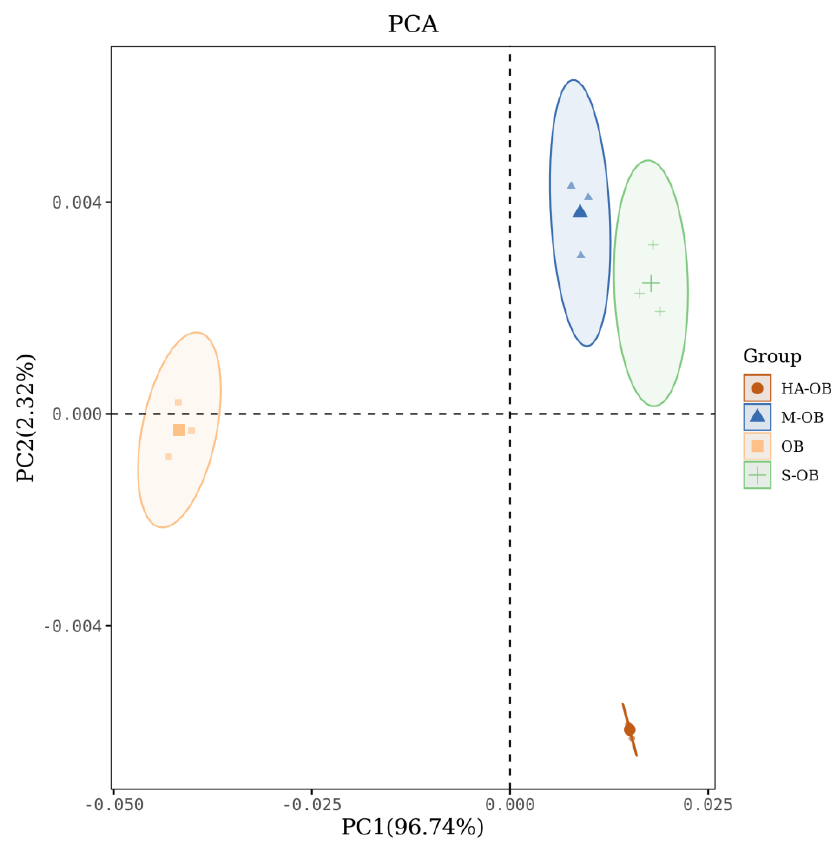
Figure 1. PCA scatter plot of electronic nose in different pretreatments. OB, Oat bran; S-OB, Steamed oat bran; M-OB, Microwaved oat bran; HA-OB, Hot air dried oat bran.